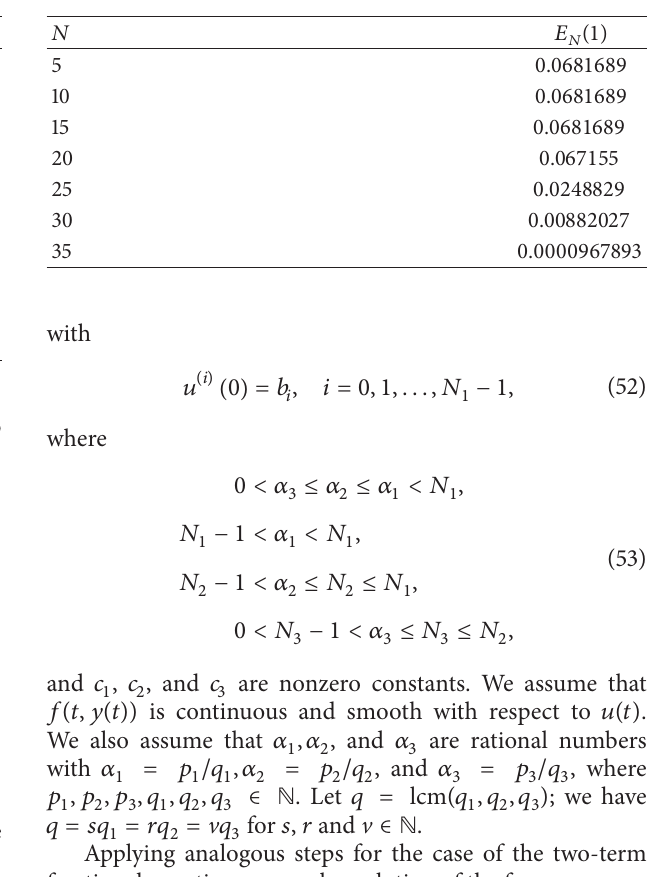
Table 2: The error of Example 4 at 𝑡 = 1 and for different values of